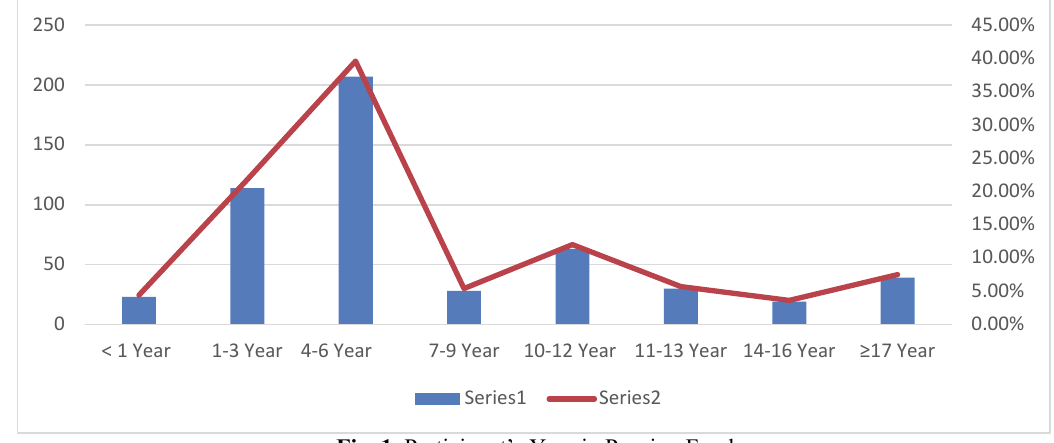
Fig. 1. Participant’s Year in Pension